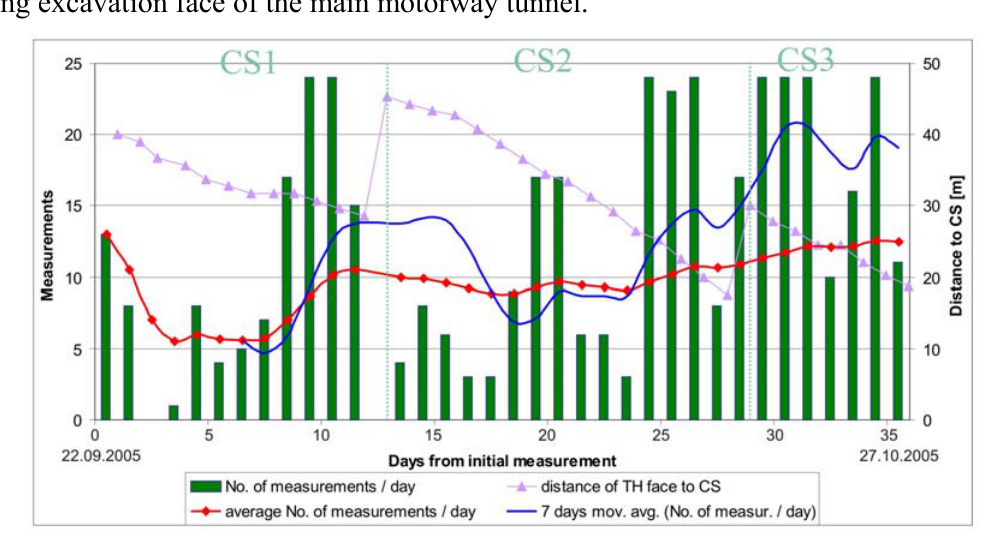
Figure 6. Number of daily performed measurements in the right tube of the exploratory tunnel with plotted average measurement rate and distance of the control station to the top heading excavation face of the main motorway